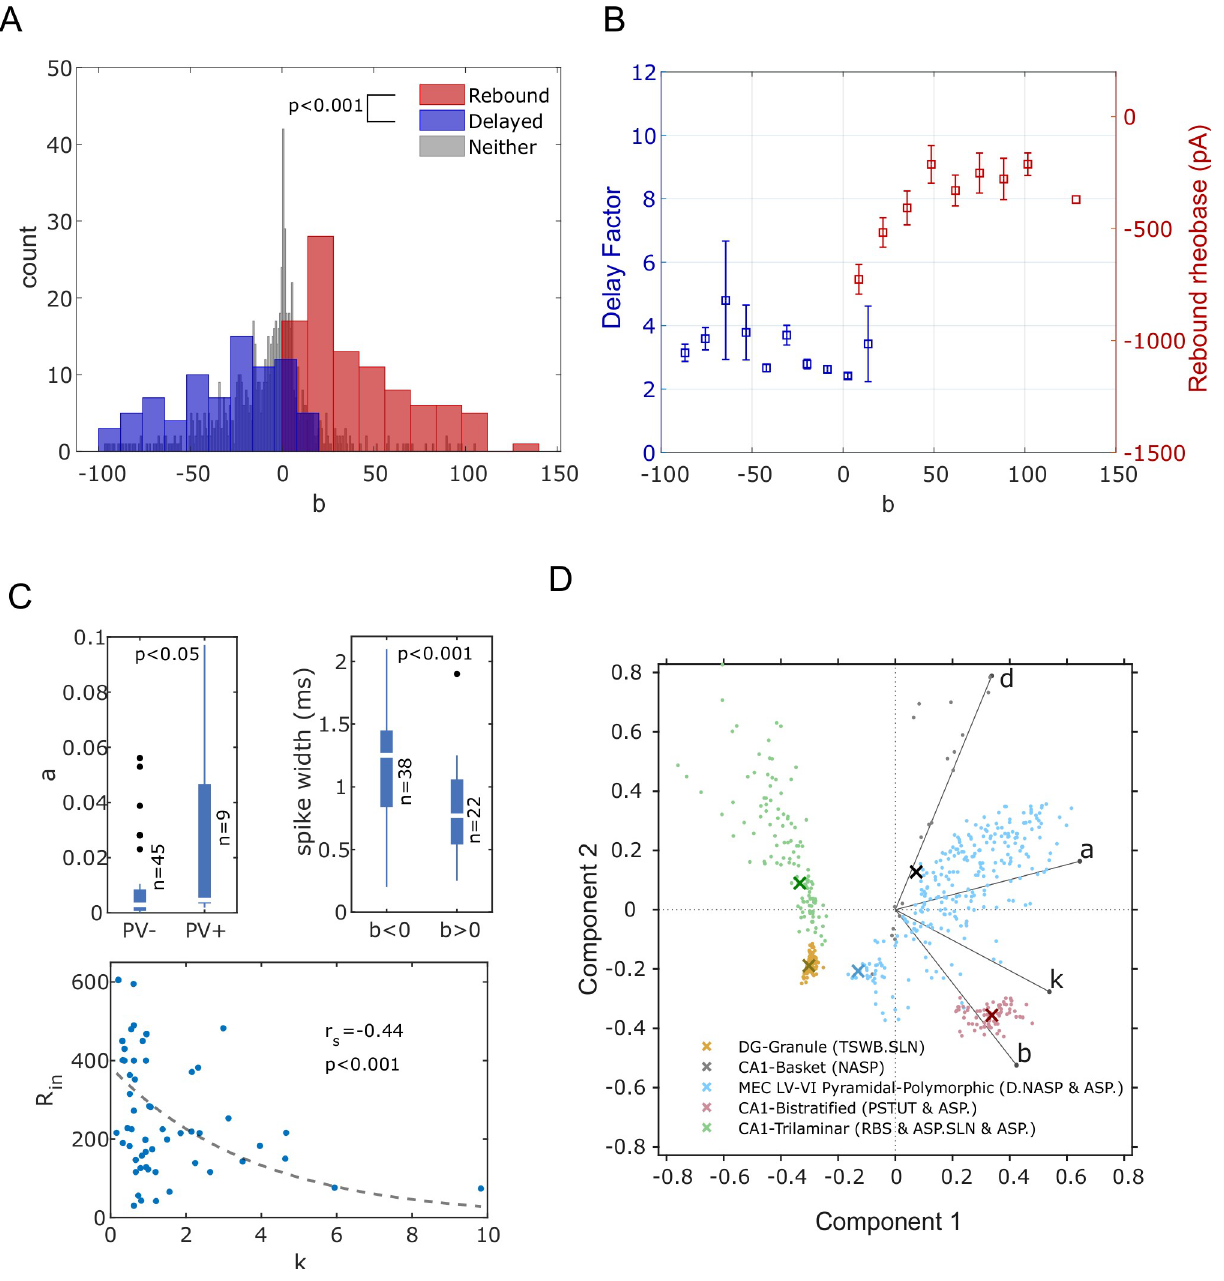
Fig 8. Relationship between model parameters and biological features. ( A ) Distribution of parameter ‘ b ’ for the models that show rebound spiking (red), delayed spiking (blue), and neither (grey). Rebound spiking types were sharply restricted to the positive region of ‘ b .’ In contrast, delayed spiking types were mostly found in the negative region (two-sample t- test). ( B ) Mean and SEM of delay factors and rebound rheobases of the models from the blue and red histogram bins respectively from A. Delay factor is the ratio between fsl and average of the first two ISIs . Rebound rheobase is the minimum magnitude hyperpolarizing current required to elicit rebound spikes. ( C ) Neuron types with positive expression of Parvalbumin (PV) have higher values for parameter ‘ a ’ than the types with negative expression of PV (one-tailed Wilcoxon Rank-Sum test; p < 0.0005 in Anderson-Darling normality test) (top-left). Neuron types with negative values for ‘ b ’ have wider spikes compared to the types with positive values for ‘ b ’ (one-tailed Student t- test) (top- right). Input resistance ( R ) of a neuron type is negatively correlated with the parameter ‘ k ’ (‘ r ’ denotes Spearman’s Rank-Order correlation coefficient, in s n = 67. An exponential fit was added for illustration only, and not used to measure correlation) (bottom). ( D ) Separation of spike pattern phenotypes in the space of first two principal components. ‘x’ denotes the best model for each type. Vectors denote the principal component coefficients of the respective parameters.